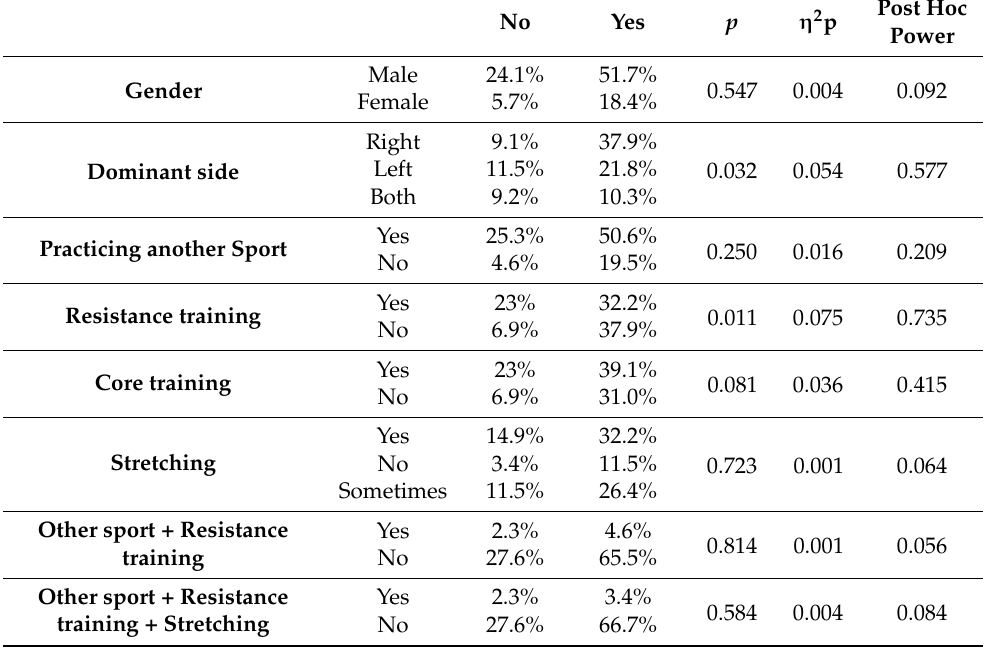
Table 4. Injured participant’s